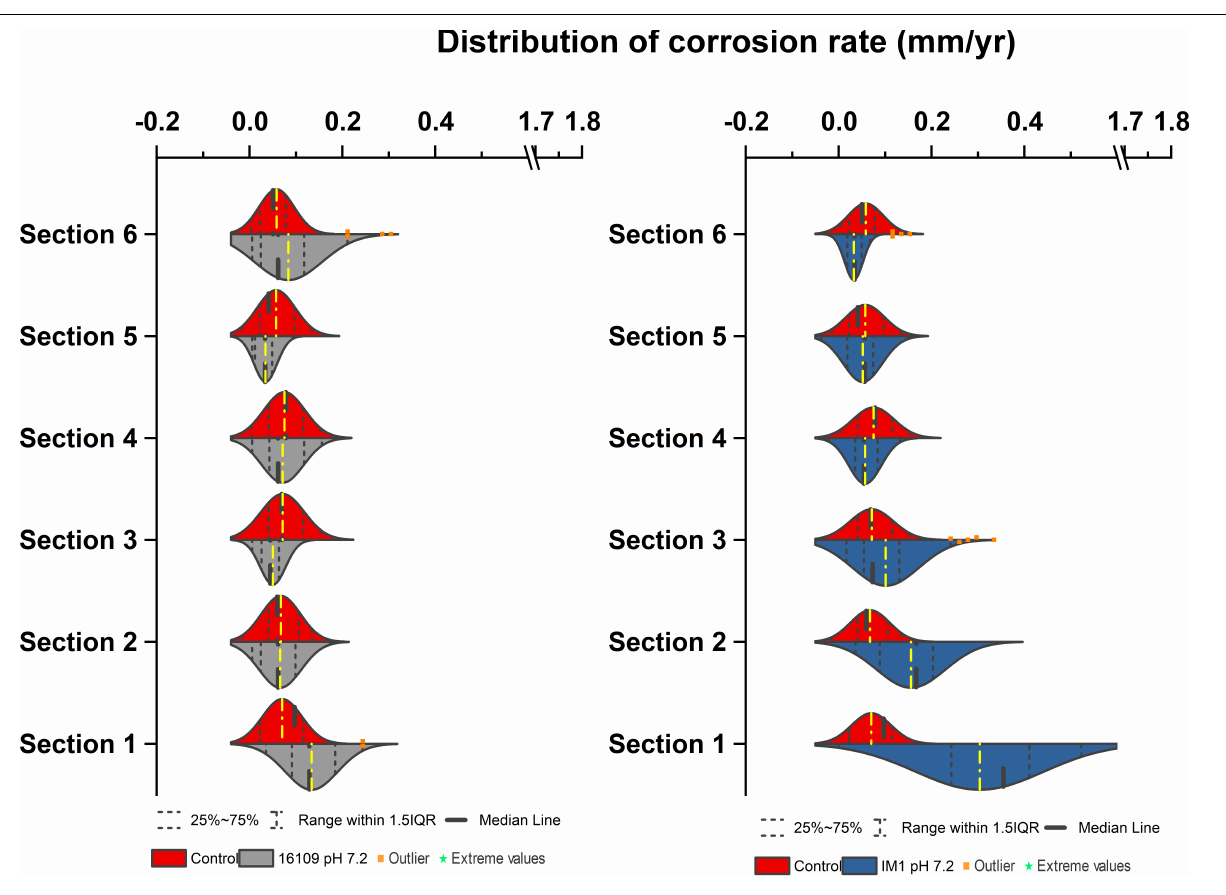
FIGURE 7 | Corrosion rates distribution (mm/yr) of D. alaskensis 16109 (left) and Methanobacterium IM1 (right) at pH 7.2 compared against abiotic control in flow system columns incubated for 7 days without flow with sand as a filling medium and operated for 14 days. Corrosion rate distribution, medium and outliers of three biological replicates are